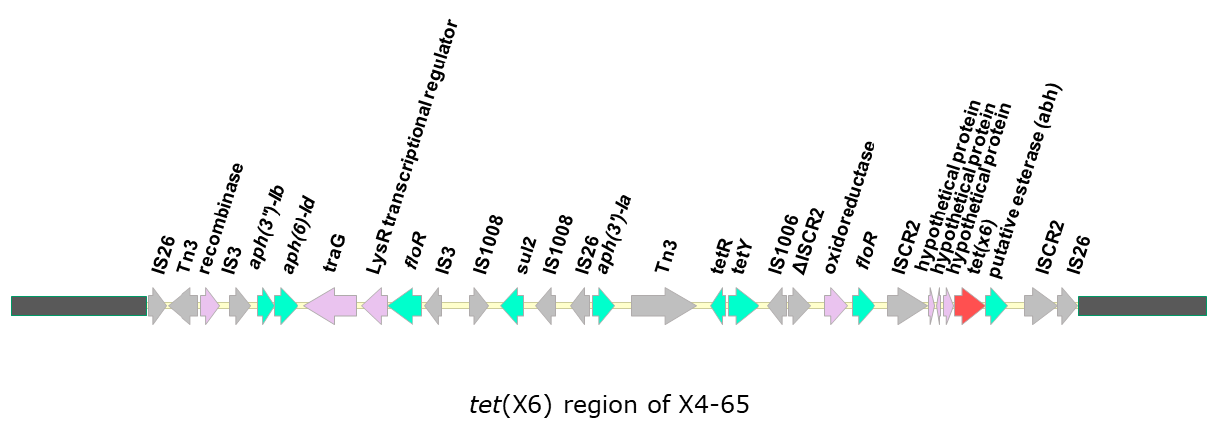
Figure 1. Genetic organization of the region surrounding tet (X6). A ~40 kb region containing tet (X6) unique to the strains analyzed in this study but absent in ab736 and ZW85-1 are shown. The open reading frames are indicated by arrows. The tet (X6) is colored in red, and other genes are colored according to their annotated functions: Green, antimicrobial resistance; grey, mobile element; purple, other